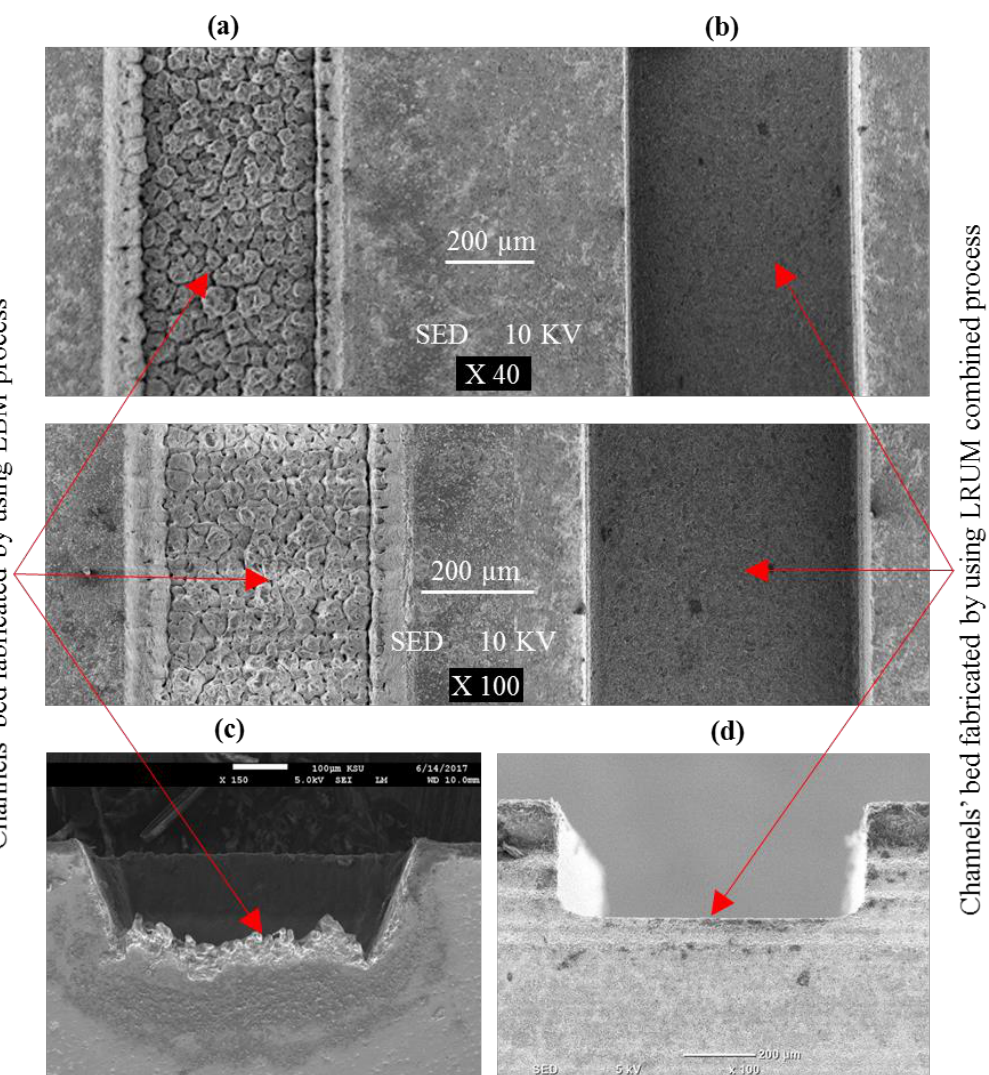
Figure 11. Comparison of the surface morphology of the fabricated channels by using LRUM comparing to LBM, ( a , b ) channels’ bed, ( c , d ) channels’